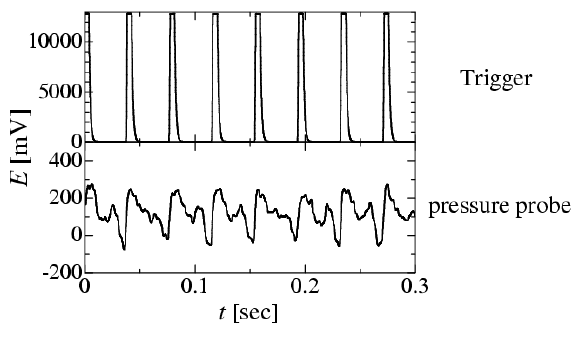
Fig. 7 Time history of static pressure signal (measurement position 1-b; FACE MODE).